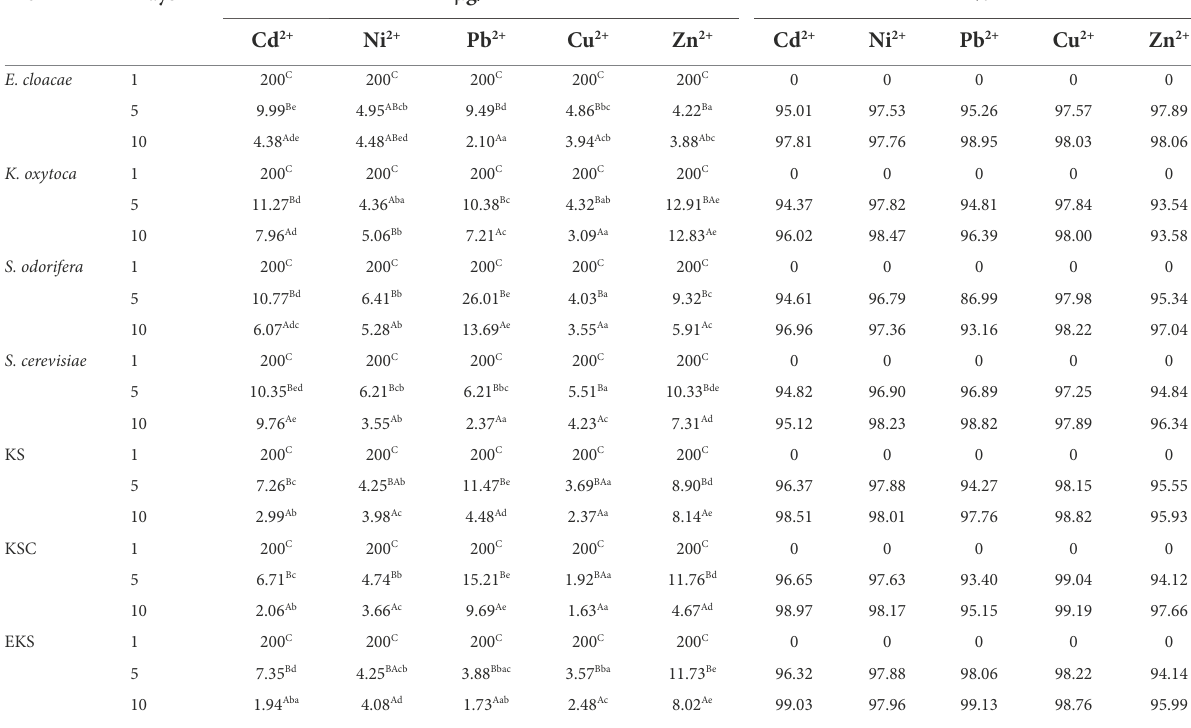
TABLE 4 Biosorption potential of the single-and mixed biofilms for removal tested HMs.